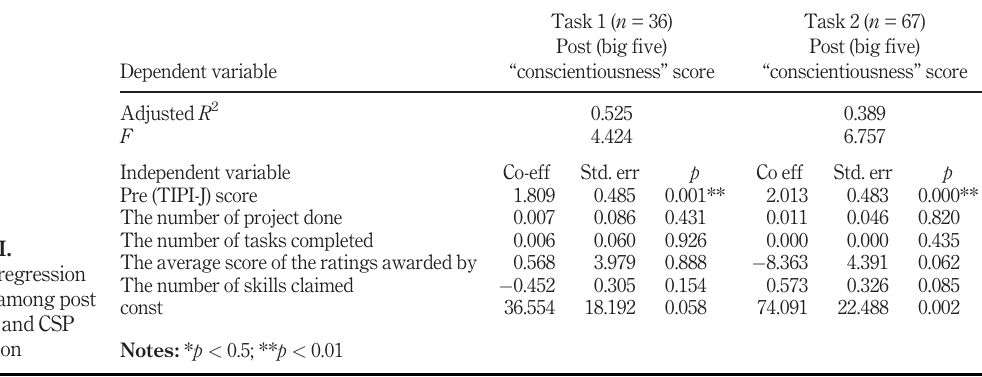
Table VI. Multiple regression analysis among post big score and CSP